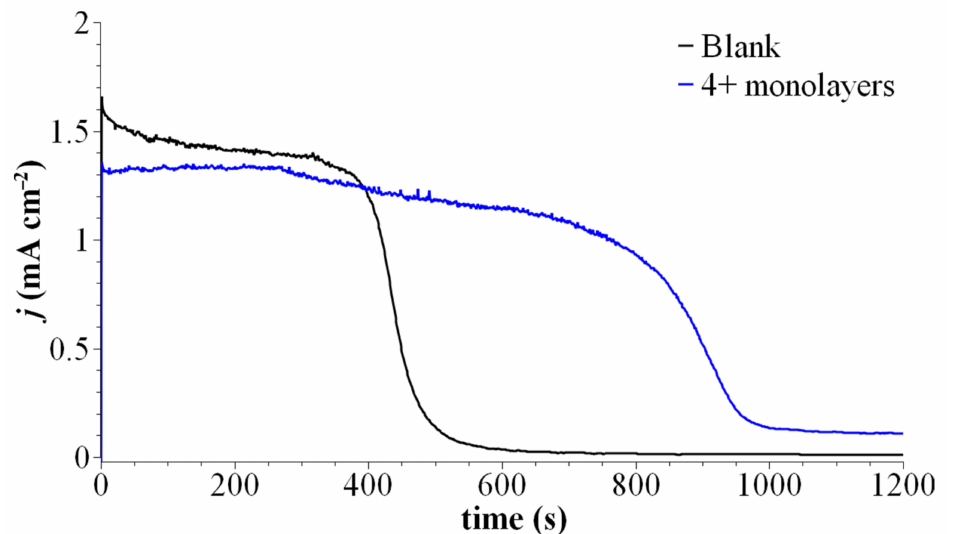
Figure 5. Chronoamperometry measurements at 0.2 V vs. RHE, at 900 rpm in H 2 -saturated H 2 SO 4 (adjusted to pH 1.8) electrolyte for blank Pt and the 4+ monolayer Cr x O y H z -coated Pt disc, where saturating gas composition was changed to 5% CO/H 2 at 300